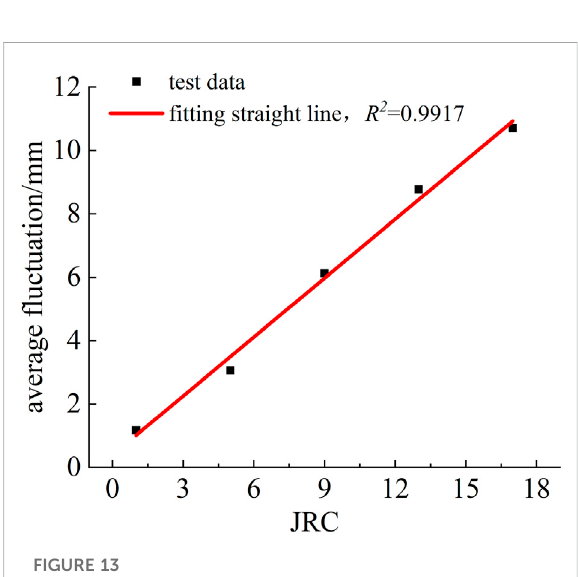
FIGURE 13 Average fl uctuation-JRC fi tting